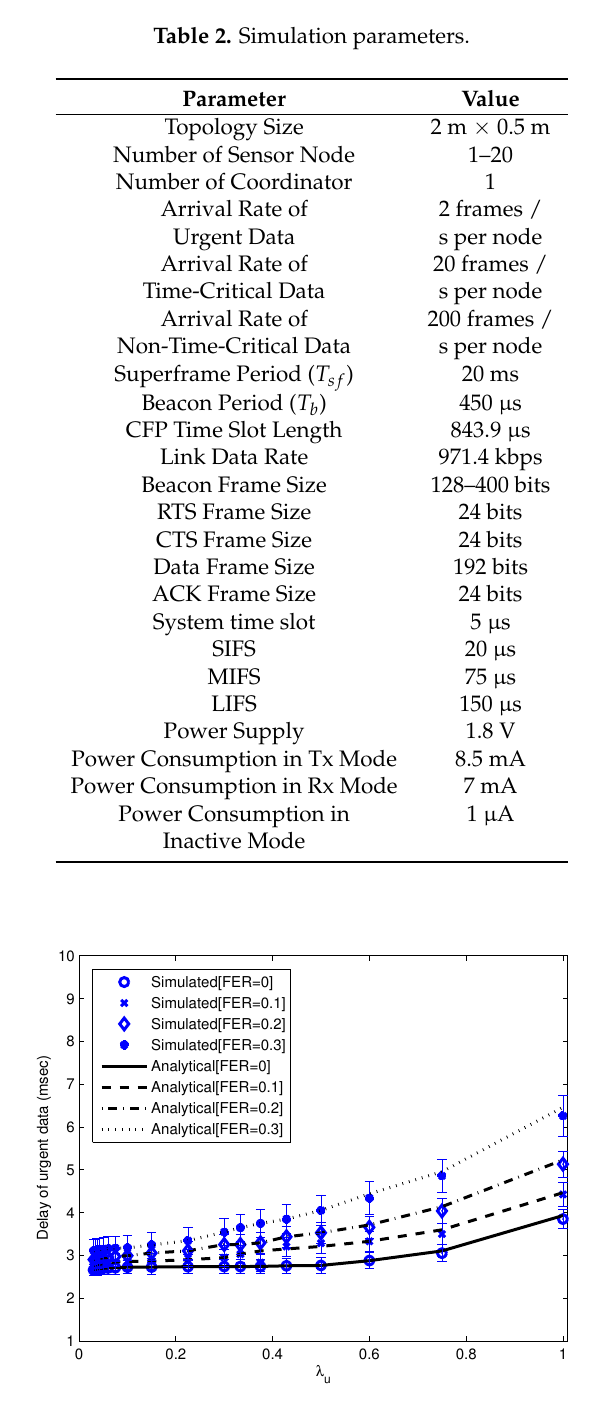
Figure 4. The average delay of urgent data vs . λ u . ( λ n = 1 frames/s per